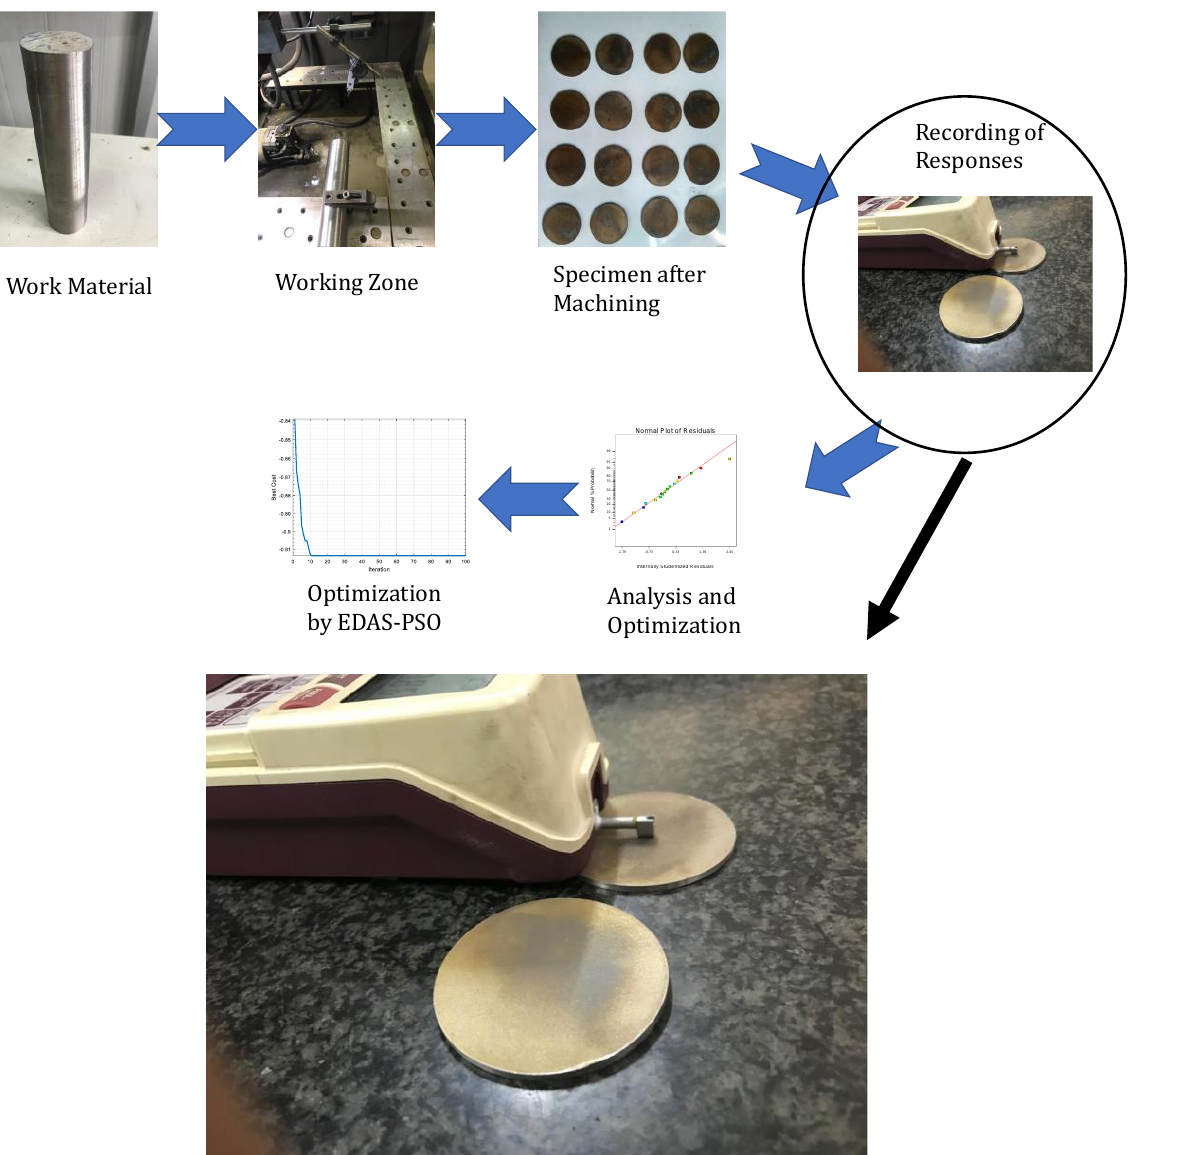
Figure 1. Process flow in the present research.